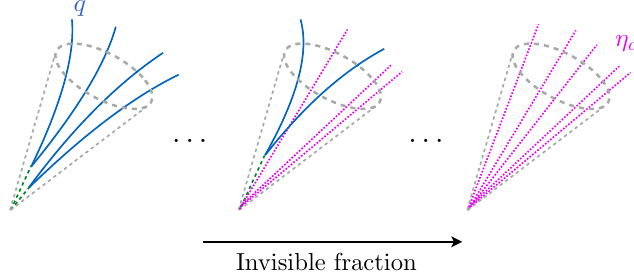
Figure 1 . The anatomy of a dark sector parton shower. Unstable dark hadrons (green dashed) decay to Standard Model quarks, q (solid blue). If all the dark hadrons are unstable, then the jet is easily mistaken for an ordinary QCD jet (left panel). However, some fraction of the dark hadrons, (cid:17) d , can be collider stable (pink dotted). If both stable and unstable hadrons are produced in a collision, the end result is a semi-visible jet (middle panel). In this case, the missing energy can be aligned along the direction of one of the jets. If all the dark hadrons are stable, then only missing energy is inferred (right panel). The LHC search strategy depends on the invisible fraction of the